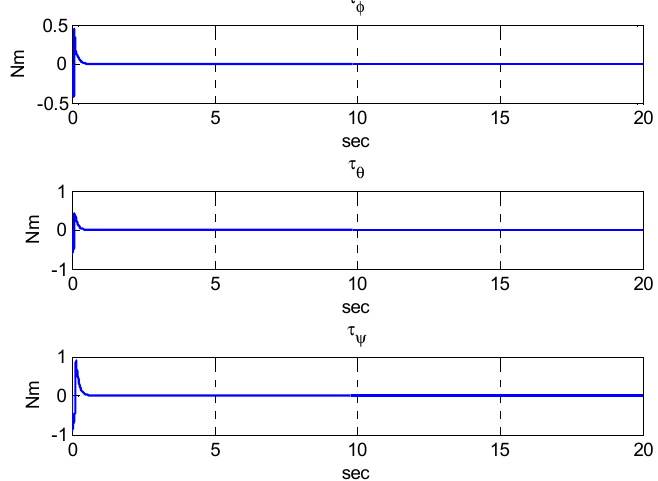
Figure 6. The turning torque with variable deviations.